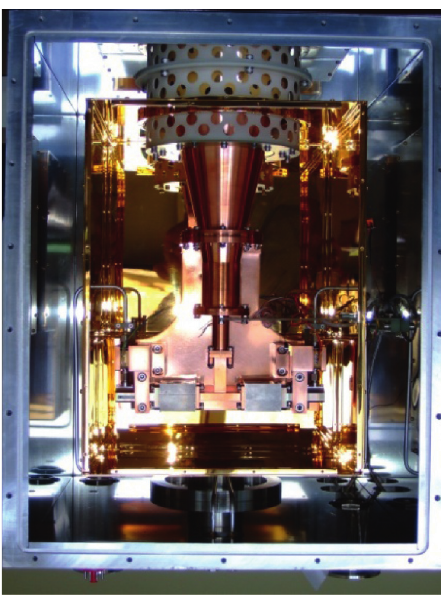
Figure 2: K-band cryogenic receiver of